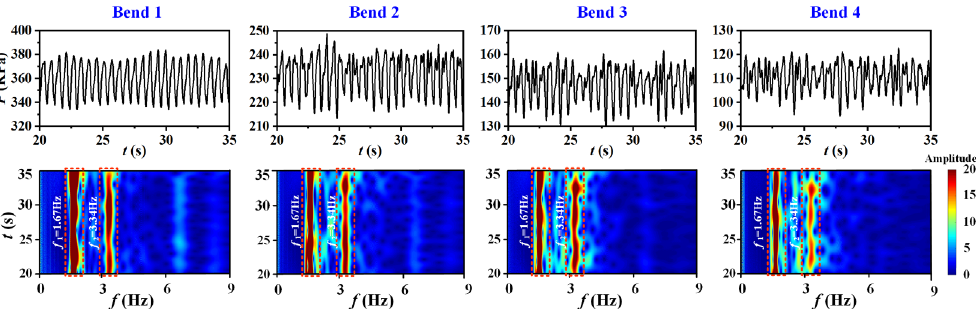
Figure 7. Time histories of the pressure acting on four bends and associated wave-let frequency spectra in the case of Q G = 6 kg/s and Q L = 144 kg/s. m-in m-in